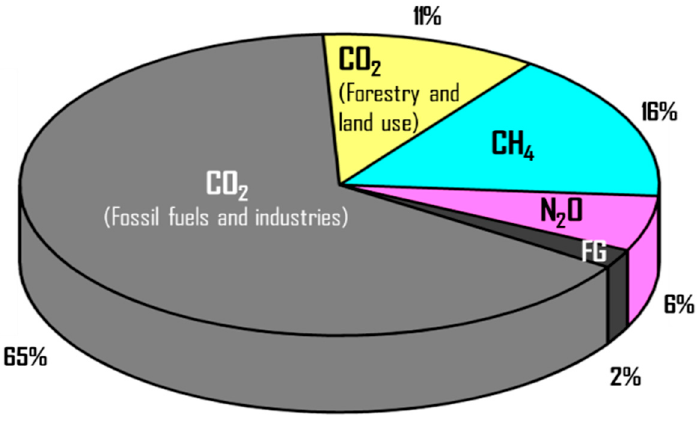
Figure 3. Global atmospheric concentrations of greenhouse gases (Data source: [13]).